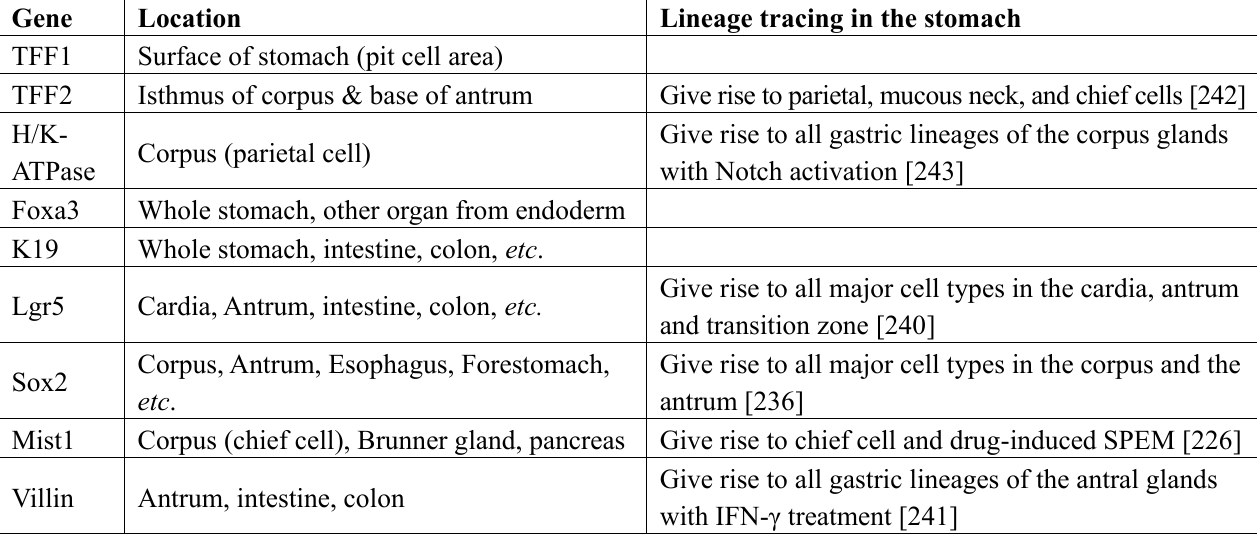
Table 4. Promoters for establishing gene expression in the